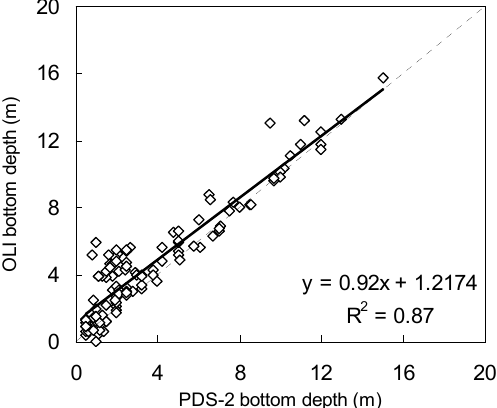
Figure 4. Scatterplot of OLI derived bottom depths and in situ PSD-2 bathymetric data measured in 133 sites of Lampi Island coastal zones. The regression line between data is plotted with equation and linear regression coefficient ( R 2 ). Dotted line shows the 1:1 line.